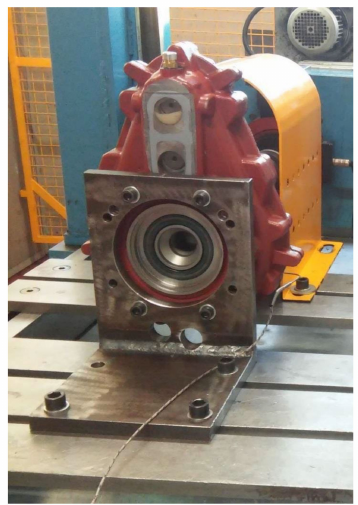
Figure 6. Experimental